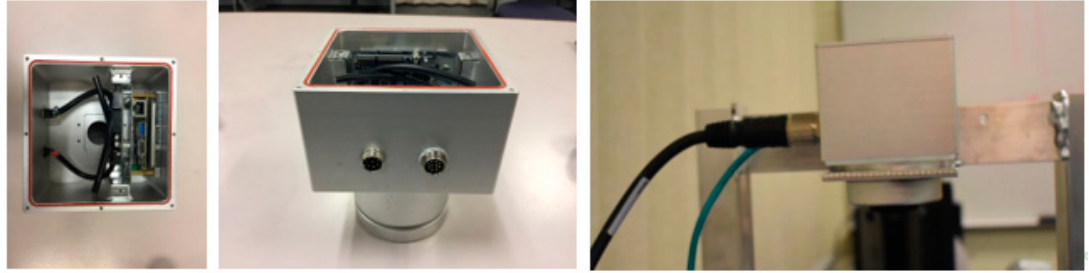
Figure 4. IP-64 enclosure of the smart camera.